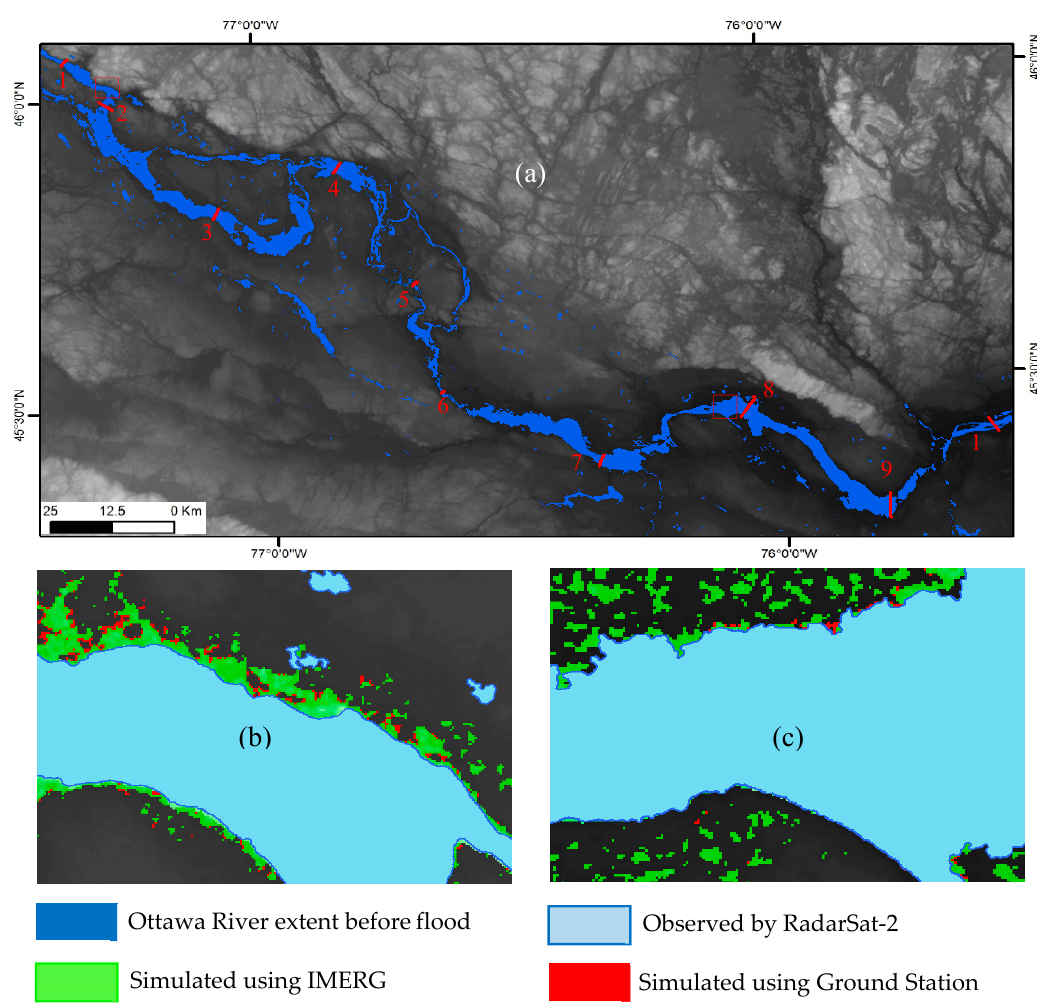
Figure 9. ( a ) Locations of topographical profiles in the study area. ( b ) and ( c ) Overlaying of simulation flood extents with the observed flood extent by RadarSat-2 during the Ottawa flood event. Each profile was created based on flood extent maps simulated using IMERG products and observed by RadarSat-2. With these profiles, absolute error (Equation 7) and pixel error (Equation 8) can be calculated, e.g., Profile 4 as shown in Figure 10.